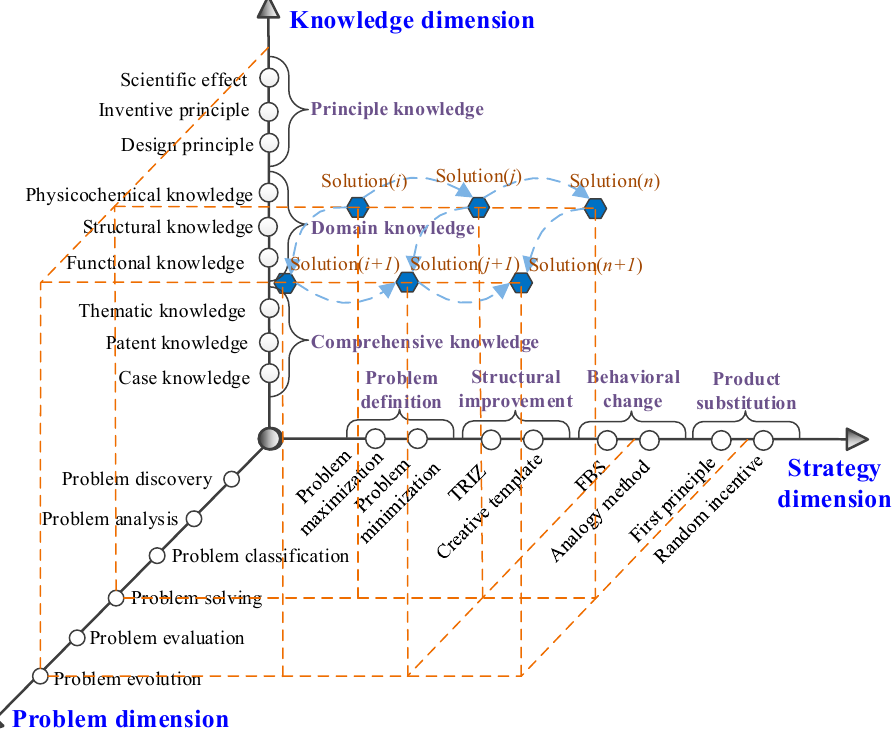
Figure 4. Product design solution evolution knowledge service dimension.